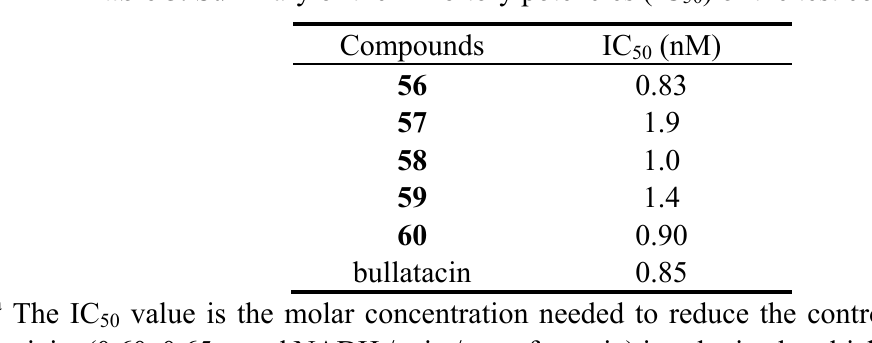
Table 5. Summary of the inhibitory potencies (IC